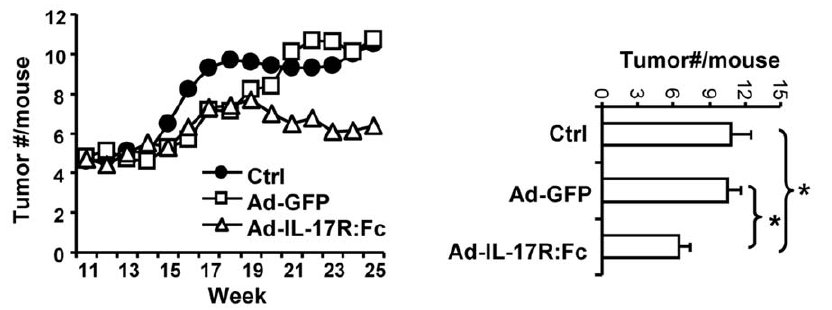
Figure 5. Neutralization of IL-17 inhibits the progression of tumors in DMBA/TPA induced cutaneous carcinogenesis. Wild type C57Bl/6 mice were topically treated once with DMBA and then twice weekly with TPA. All mice developed cutaneous tumors at 12 weeks. The mice were divided (10 mice/group) and treated intravenously with adenovirus encoding GFP (Ad-GFP), IL-17R:Fc (Ad-IL-17R:Fc) or left untreated (Ctrl) at week 12 and 16. All mice were continuously treated with TPA twice a week throughout the experiments. The tumor growth was monitored weekly. Bar graph shows the mean tumor number per mouse + / 2 SEM at the end of experiments (* P , 0.05). Data are representative of 2 independent experiments.